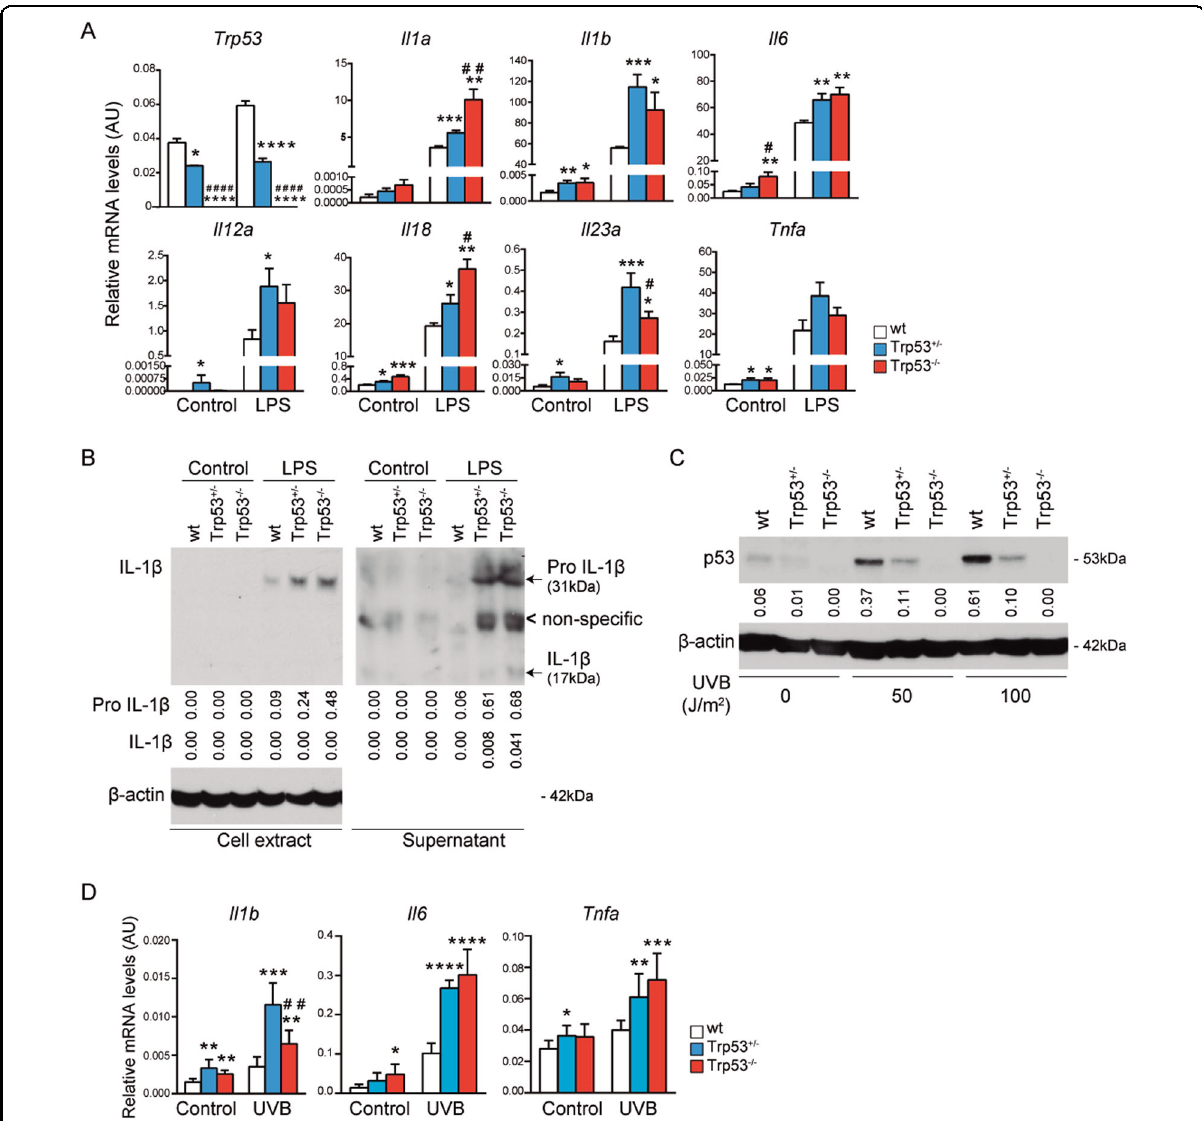
Fig. 3 Loss of one Trp53 allele leads to an increased pro-in fl ammatory cytokine expression in untreated and LPS and UVB-treated BMDM cells. A Relative mRNA expression of the indicated genes in BMDMs from p53 WT, HEM, and KO mice untreated (control) and treated (LPS, 100ng/ml, 4 h). Biological replicates were quanti fi ed in four independent experiments. B Expression of IL-1 β pro-form (31kDa) and active isoform (17kDa) in total cell extracts and supernatants of BMDMs from WT, HEM, and KO mice untreated (control) and treated (LPS, 100ng/ml, 4 h). Relative expression values in cell extracts were referred to β -actin expression. Representative image of a western blot analysis from at least two independent experiments is shown. C Expression of p53 in BMDMs from WT, HEM, and KO mice untreated and irradiated with UVB (50 or 100J/m 2 , 24h). Relative expression values were referred to β -actin expression. Representative image of a western blot analysis from two independent experiments is shown. D Relative mRNA expression of the indicated pro-in fl ammatory cytokine genes. BMDMs from WT, HEM, and KO mice were untreated and treated with UVB (50J/m 2 , 1 h). Biological replicates in three independent experiments were analyzed. In A and D , bars represent mean values ± SEM. AU arbitrary units. Signi fi cant differences and p values were derived from an unpaired t -test, two-tailed. WT vs HEM or KO: **** p value < 0.0001, *** p value< 0.0005, ** p value < 0.005, * p value< 0.05. HEM vs KO: #### p value < 0.0001, ## p value < 0.005, # p value <